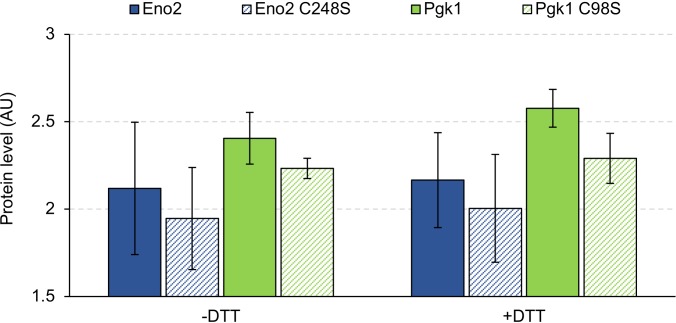
Effect of cysteine substitutions on the expression levels of Eno2 and Pgk1.C248S: substitution of cysteine 248 with serine; C98S: substitution of cysteine 98 to serine. Proteins were analyzed in low-copy conditions.